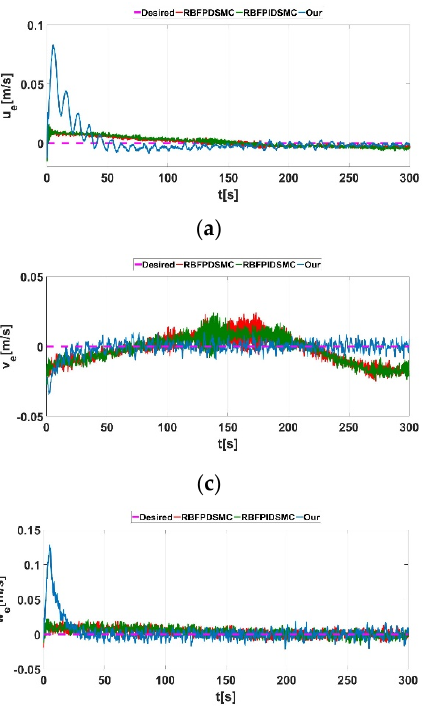
; ( c ) 𝑦 ; ( d ) 𝜃 𝑒 ; ( e ) z 𝑒 ; ( f ) 𝜓 𝑒 𝑒 e ; ( b ) ϕ e ; ( c ) y e ; ( d ) Θ e ; ( e ) z e ; ( f ) ψ e .